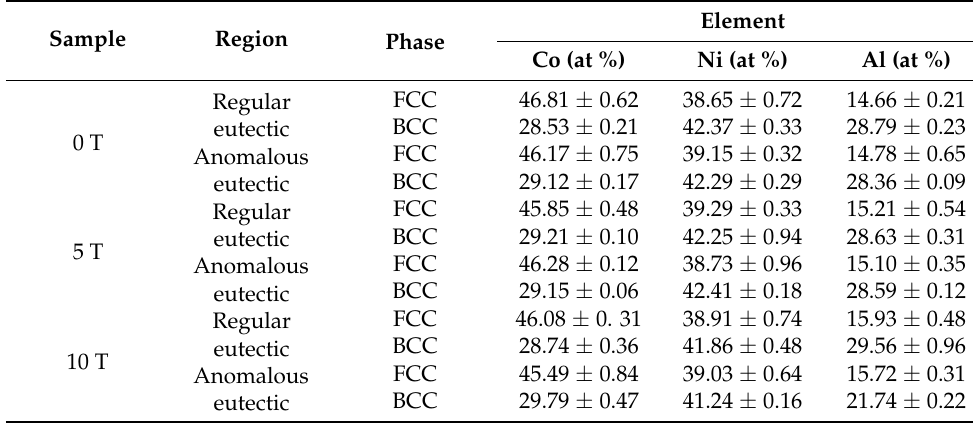
Figure 8. EDS results for the ( a ) 0 T sample; ( b ) 5 T sample; ( c ) 10 T sample. (The subscripts 1–3 for a, b and c denote the EDS mapping results of Co, Ni and Al elemental composition, respectively). Table 2. EDS results for the 0 T, 5 T and 10 T samples.